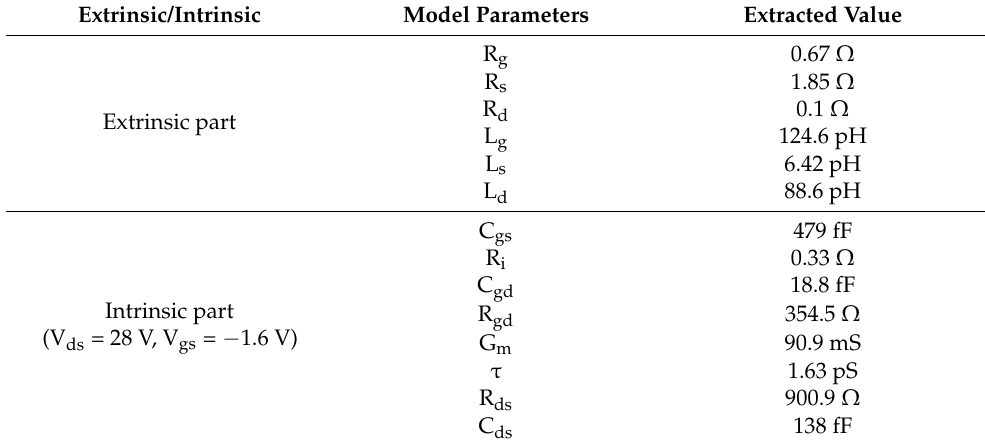
Table 1. Initially extracted extrinsic and intrinsic parameters of an ISV-type 4 × 50 μ m GaN HEMT.